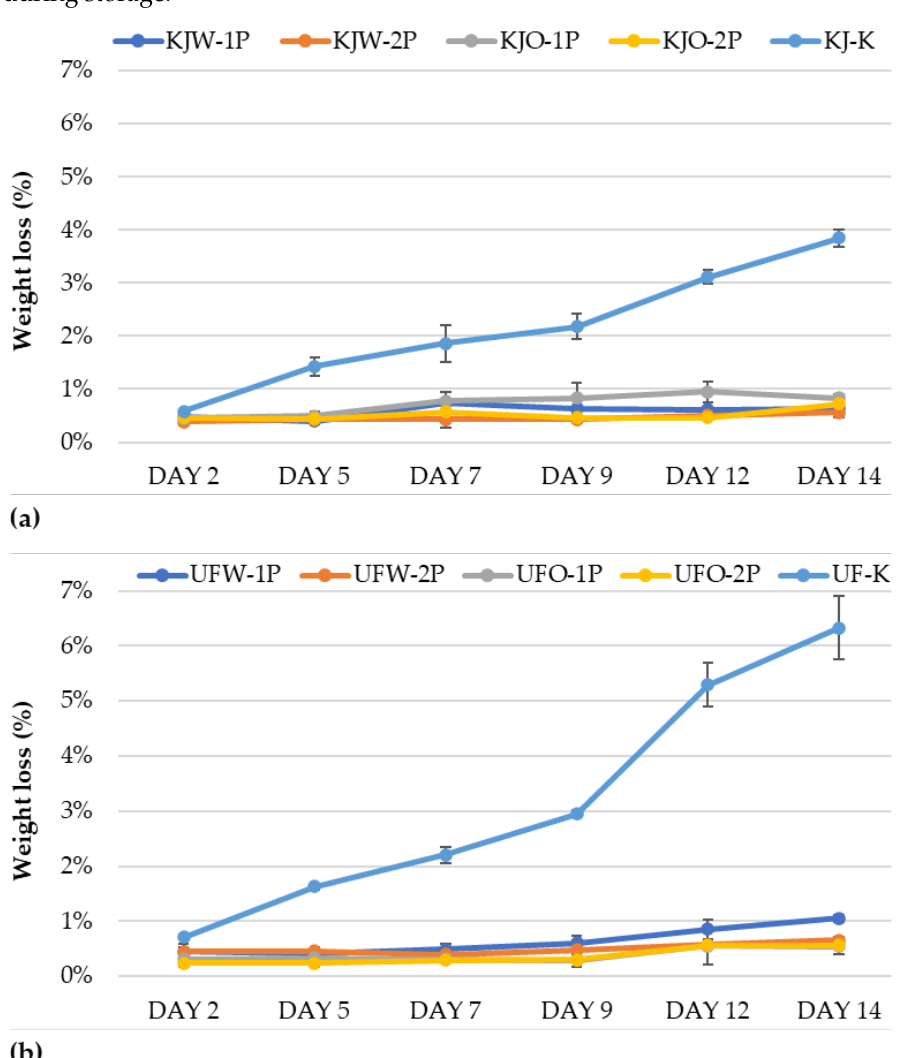
Figure 4. Weight loss during the storage of control and MAP ( a ) ‘Kántorjánosi’ and ( b ) ‘Újfehértói fürtös’ sour cherries with different washing pretreatments.